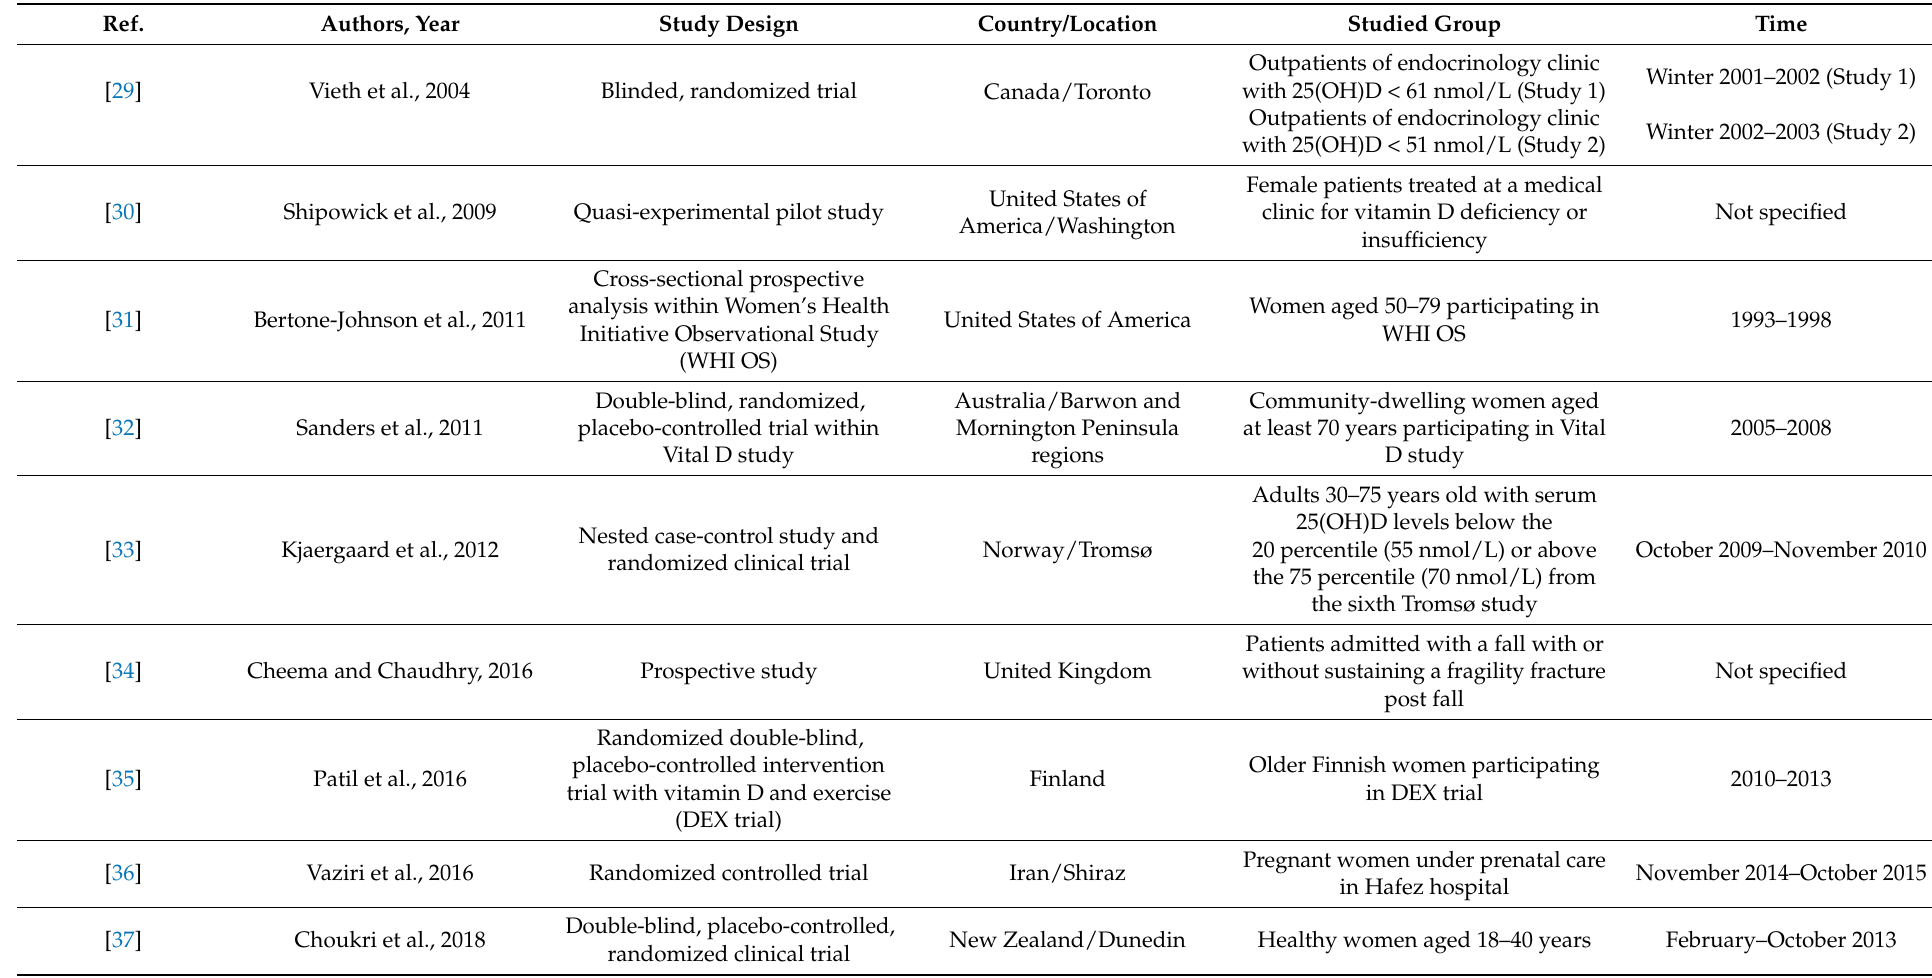
Table 2. The study design and basic details of the studies included in the systematic review.